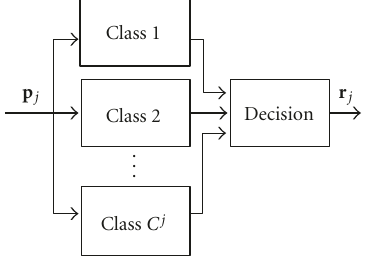
Figure 7: Scheme of the classification